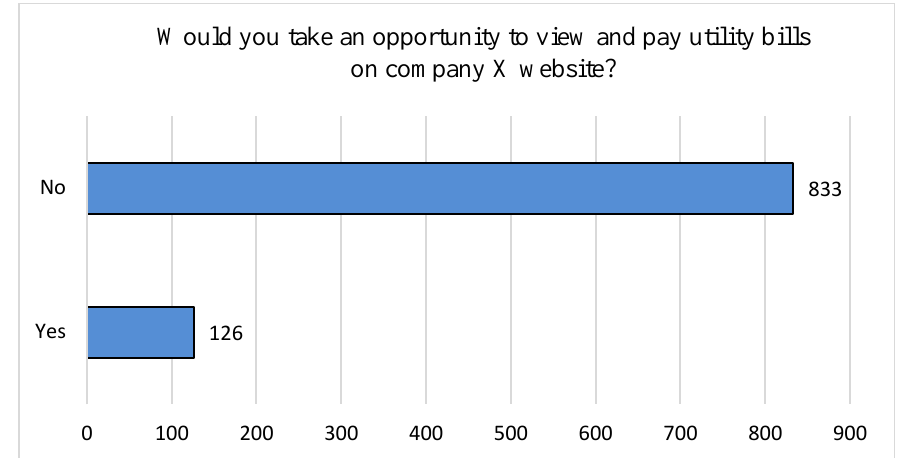
Fig. 5. The desire of the tenants of the company to take an opportunity to view and pay utility bills on the company